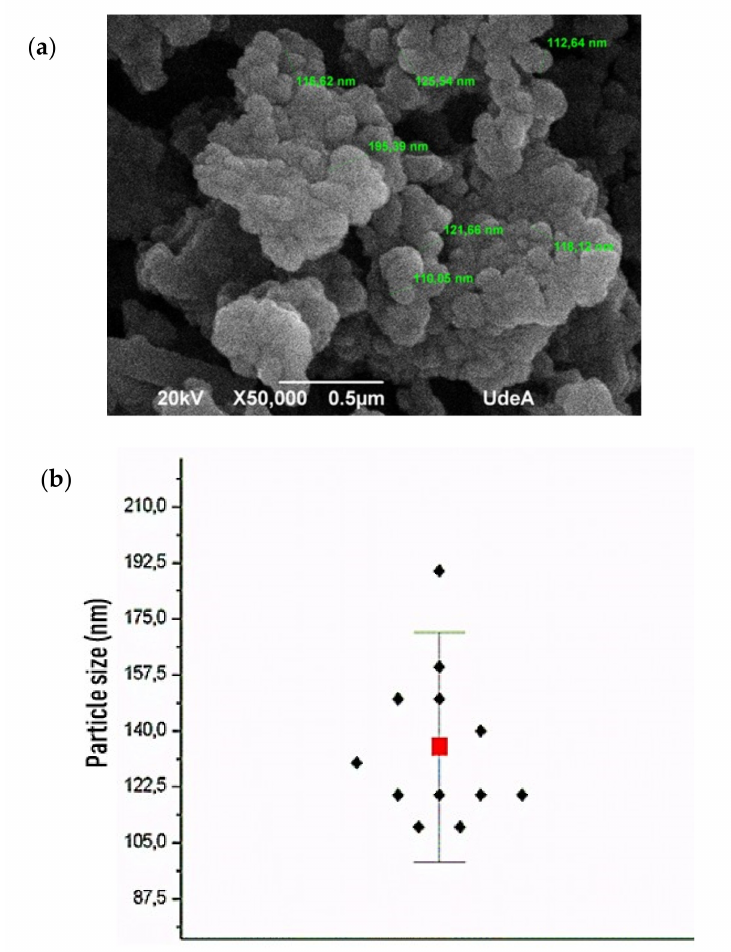
Figure 3. Obtained Al 2 O 3 nanopowder before colloidal dispersion preparation ( a ) SEM image and ( b ) average particle size (red box) and jittered dot plot (black